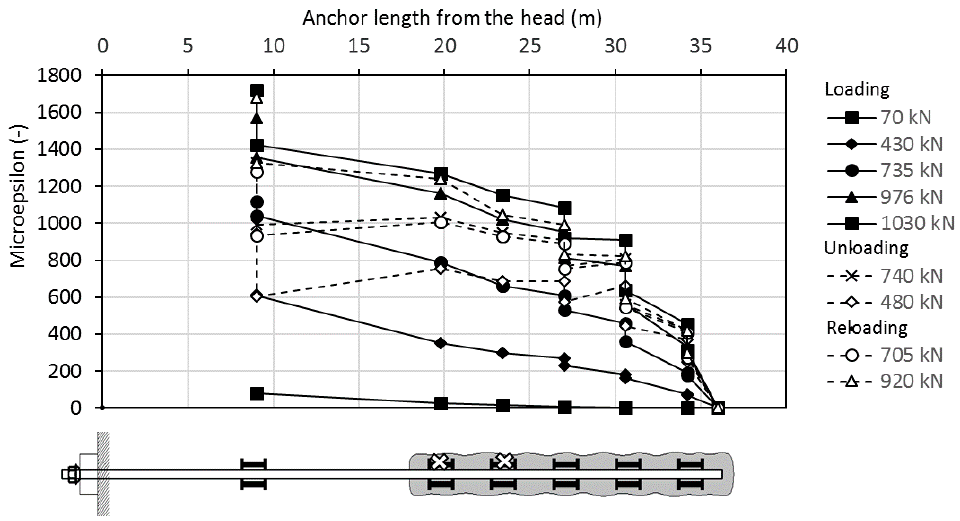
Figure 5. Strain readings during loading test.